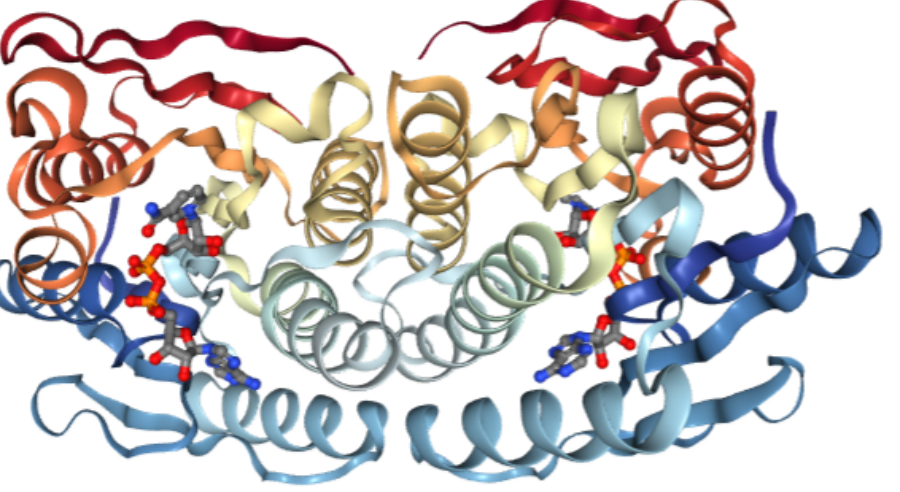
Figure 4. 3D structure of human dihydropteridine reductase (1HDR). The monomers are stabilized by NADH molecules.